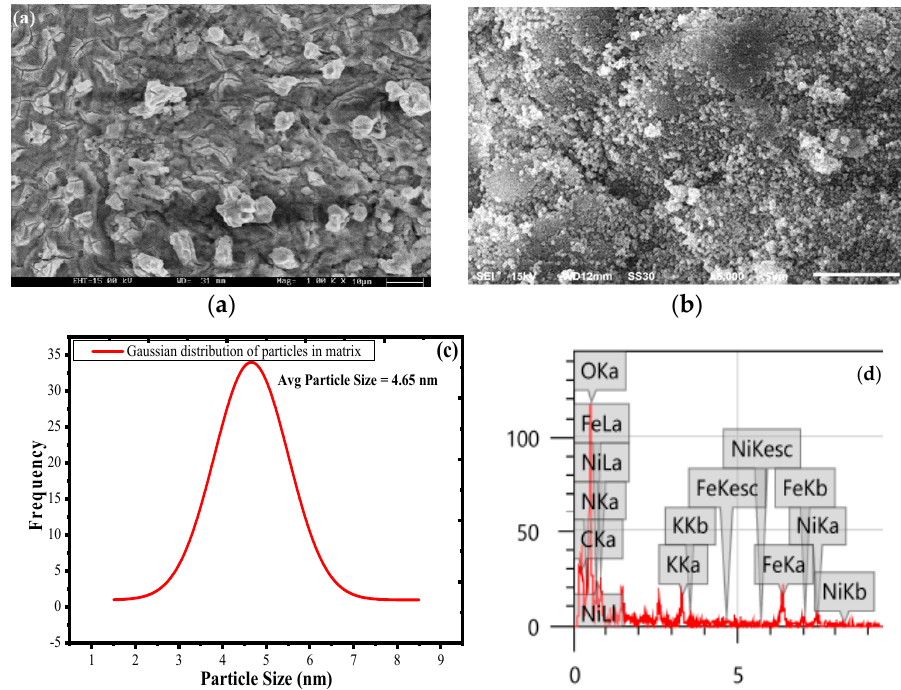
Figure 3. Scanning electron microscopy images of: ( a ) chitosan at 10 μ m scale, ( b ) chitosan-ascorbic acid@NiFe 2 O 4 at 5 μ m scale, ( c ) the Gaussian distribution of particle size, and ( d ) energy dispersive